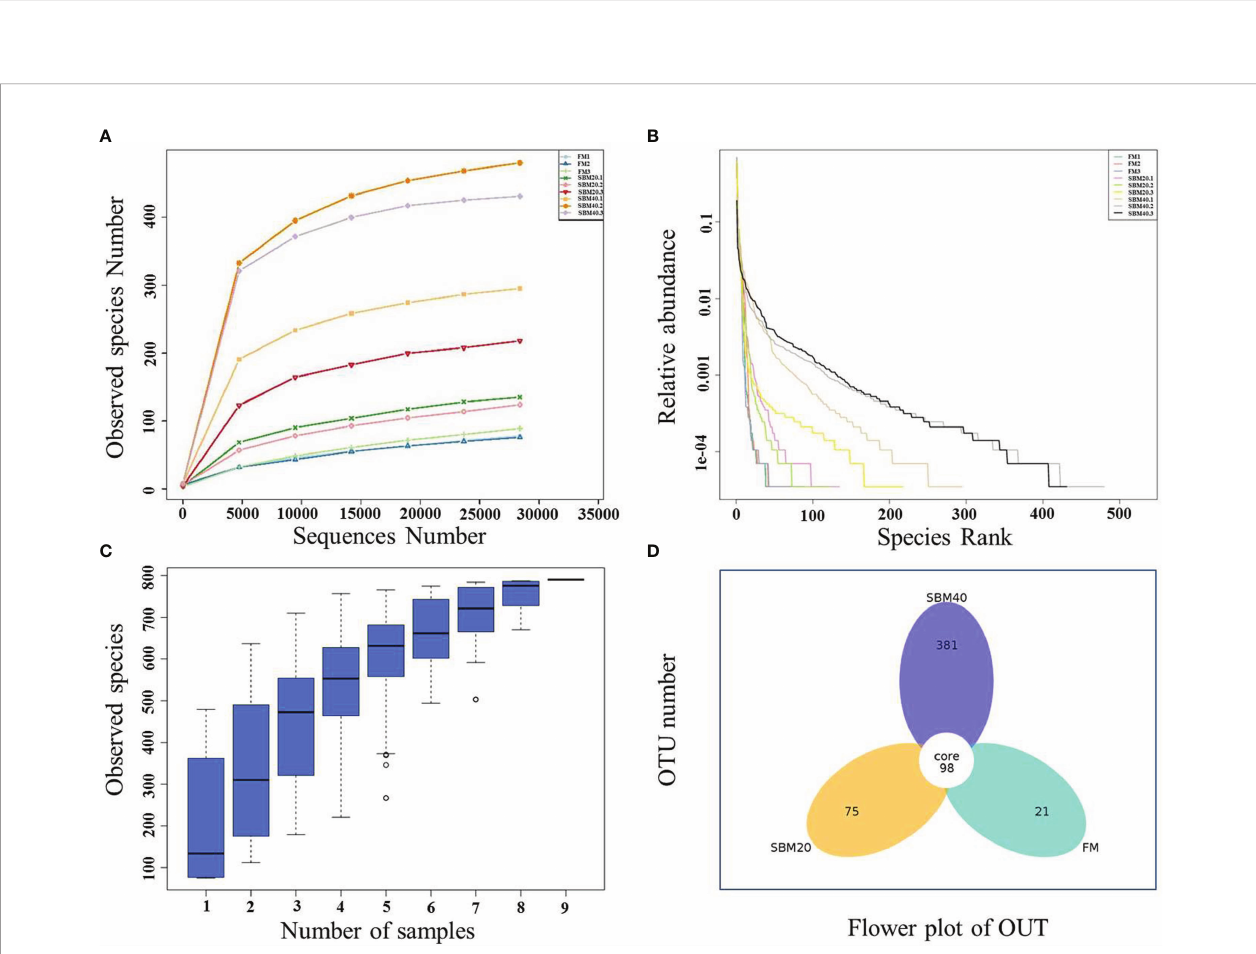
FIGURE 3 | The complexity analysis of intestinal fl ora in soybean meal-induced enteritis of pearl gentian grouper ( n = 3). (A) Rarefaction curve. (B) Rank abundance. (C) Species accumulation boxplot. (D) OTU fl ower